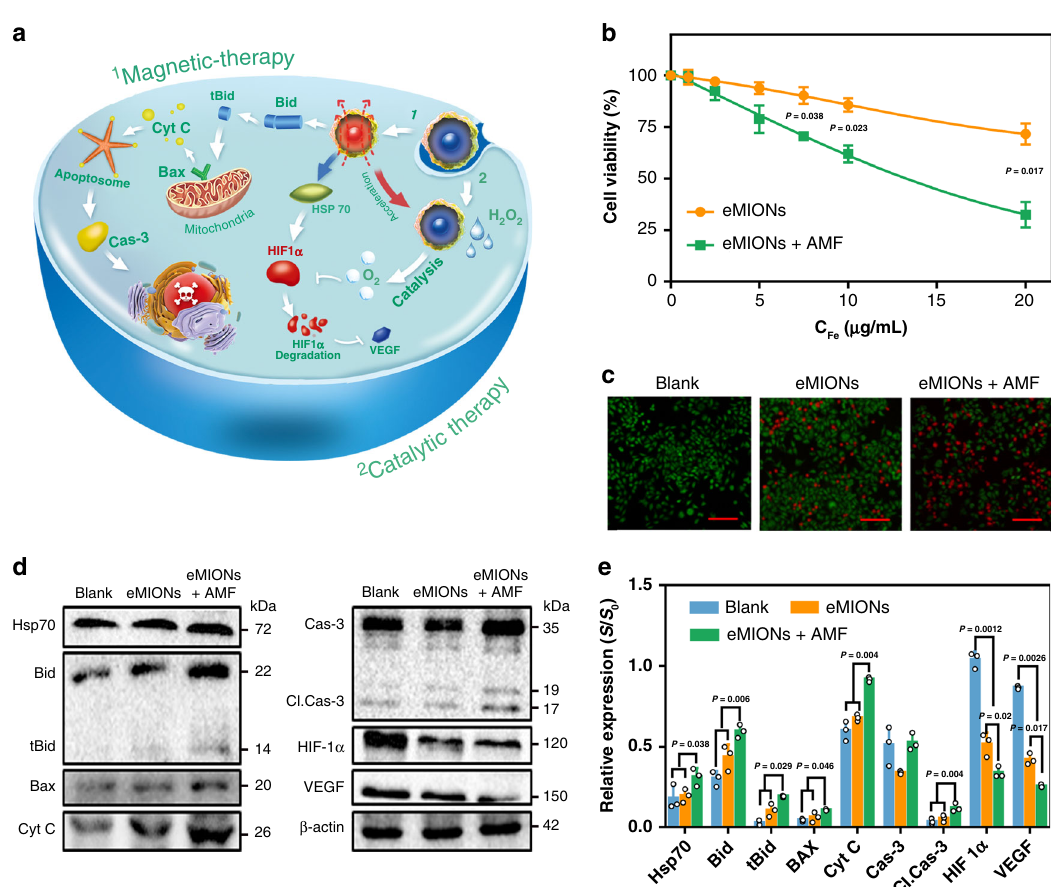
Fig. 4 In vitro studies of encapsulin-produced magnetic iron oxide nanocomposites (eMIONs). a Schematic illustration of magneto-catalytic therapy by eMIONs and proposed cellular pathways. b Viabilities of A549 cells receiving different concentrations of eMIONs with/without alternative magnetic fi eld (AMF). Data are presented as mean ± SD ( n = 5 biologically independent samples). c Fluorescence image of AM/PI stained A549 cells after therapy. Scale bar: 50 μ m. d , e Detection of apoptosis and HIF-1 α -related pathways in A549 cells after different treatments by western blot ( d ) and its semiquantitative analysis ( e ). The samples derive from the same experiment and that blots were processed in parallel. Data are presented as mean ± SD ( n = 3 biologically independent samples). One of three repetitions with similar results is shown for ( c ) and ( d ). Statistical signi fi cance was calculated with two-tailed Student ’ s t test ( b , e ), with P values showed in the fi